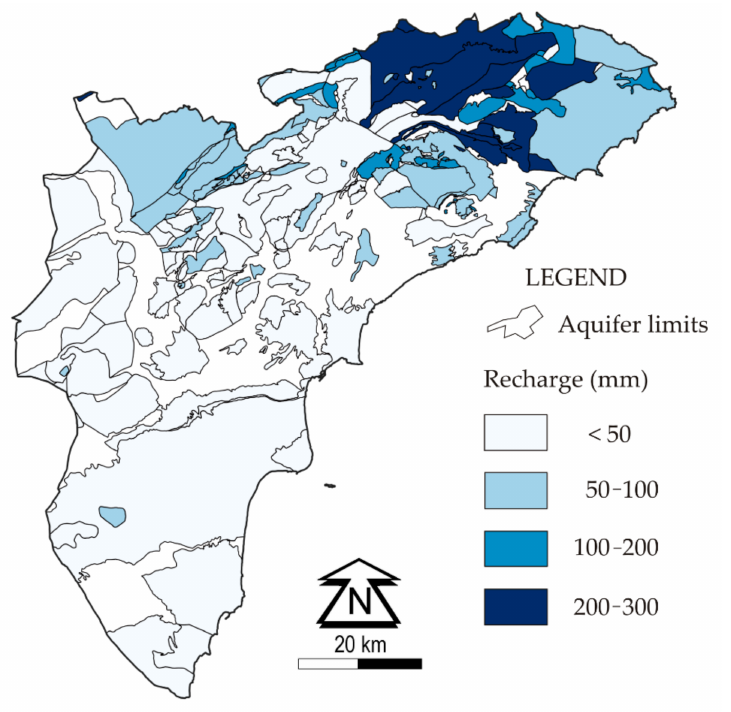
Figure 10. Distribution of annual mean recharge from precipitation for the aquifers of